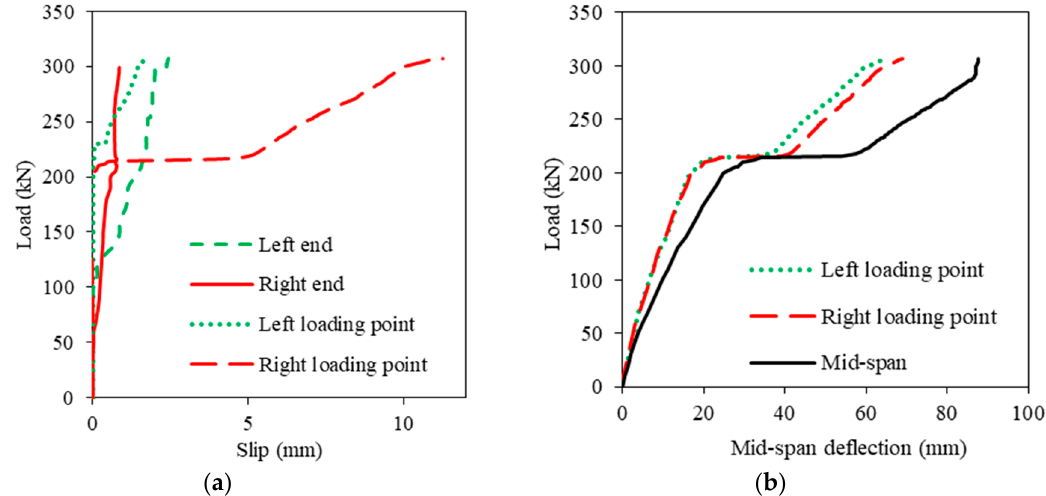
Figure 7. ( a ) Load versus slip at the beam end curves, and ( b ) Load versus mid-span deflection curves in Beam 2.